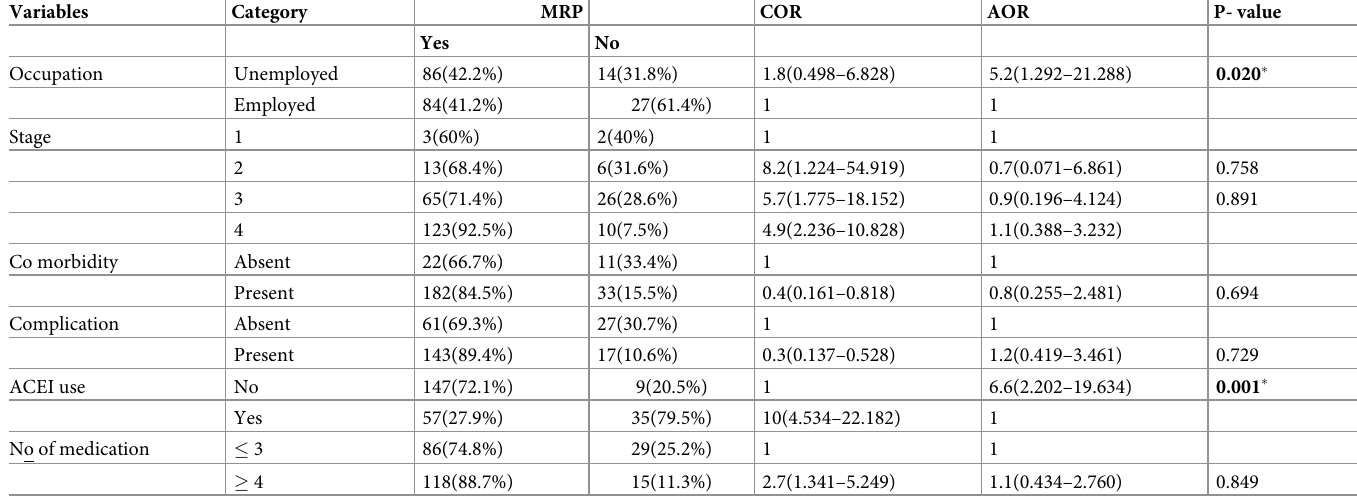
Table 6. Predictors of MRPs among CKD patients having follow up at renal clinic of St’s Paul’s Hospital Millennium Medical College, Addis Ababa, Ethiopia, June -August,